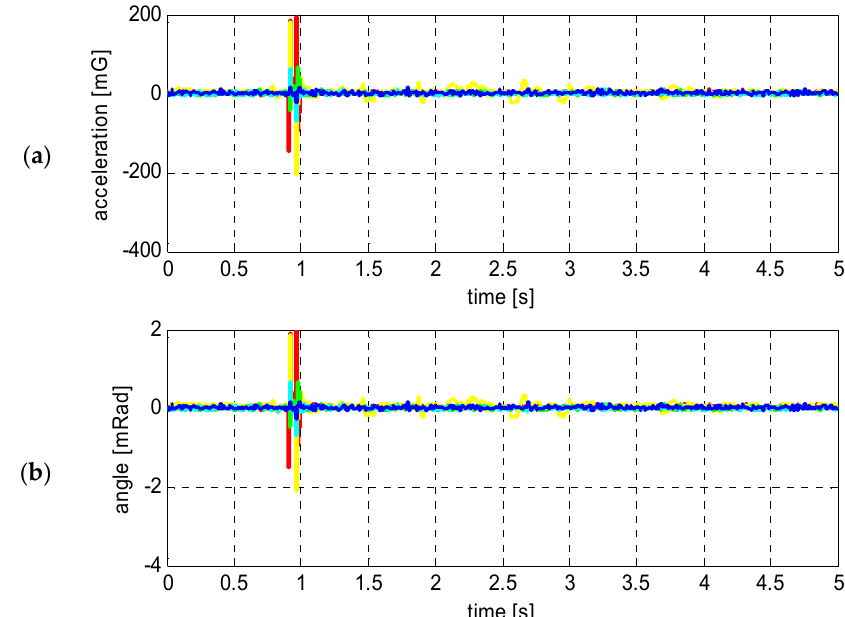
Figure 25. The results of the single impulse test: ( a ) Time–acceleration; ( b ) Time–angle. Material: saclSi 1; Isotropic pressure 20 kPa; Amplitude 8.6 V; Impulse duration 50 ms (– the top sensor, S1, – the second sensor from the top, S2, – the third sensor from the top, S3, – the fourth sensor from the top, S4, – the bottom sensor, S5).